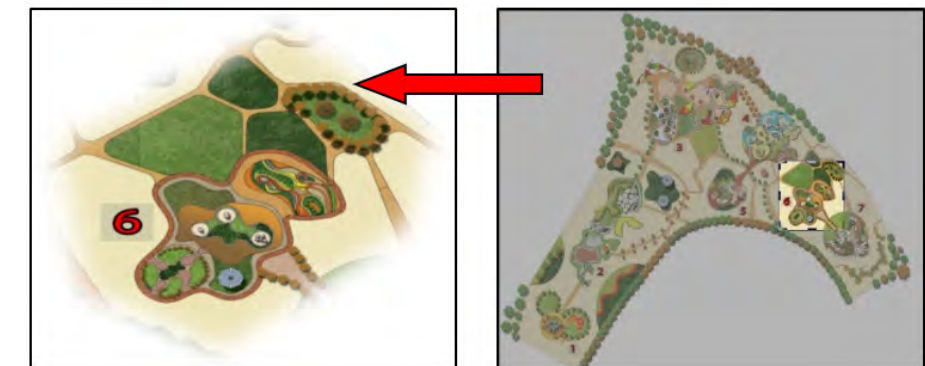
Figure 22. The location of “Natural Trail” zone